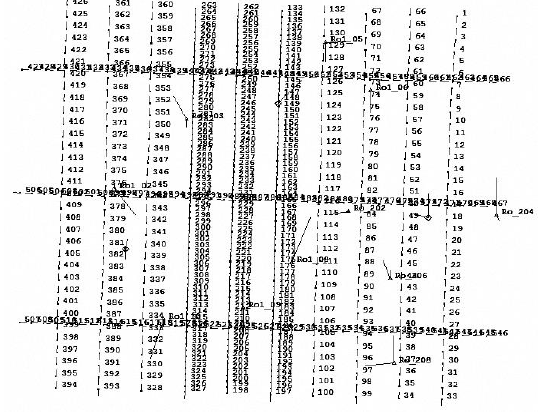
Figure 10: Flight layout in Rome [Italy], 546 images, 13 flight lines.